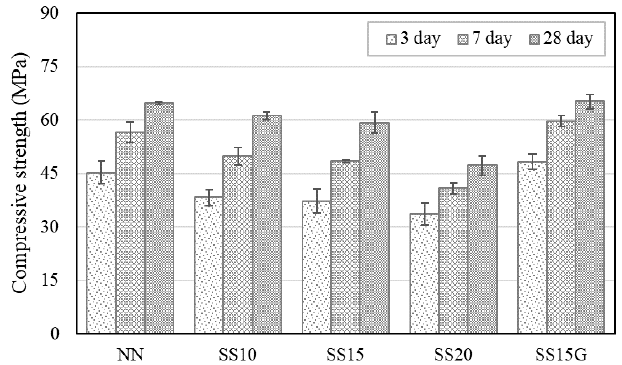
Figure 6. Test results of compressive strength at three different time points.